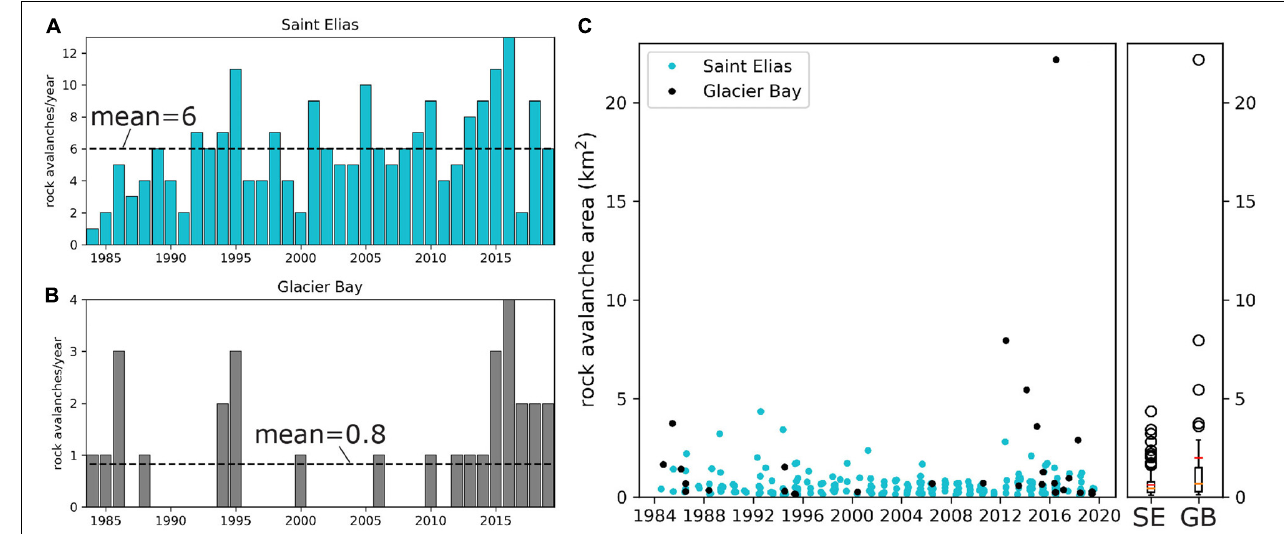
FIGURE 13 | Histograms showing the distribution of rock avalanches per year in the (A) Saint Elias (SE) and (B) Glacier Bay National Park and Preserve (GB) study areas. Data for GB are from Bessette-Kirton and Coe (2016) and Supplementary Table S5 . (C) Comparison of rock avalanche areas for 214 and 30 rock avalanches in the SE and GB study areas, respectively, between 1984 and 2019. Rock avalanche data for the Saint Elias study area do not include possible earthquake-triggered events (three) and each two-part failure is only counted